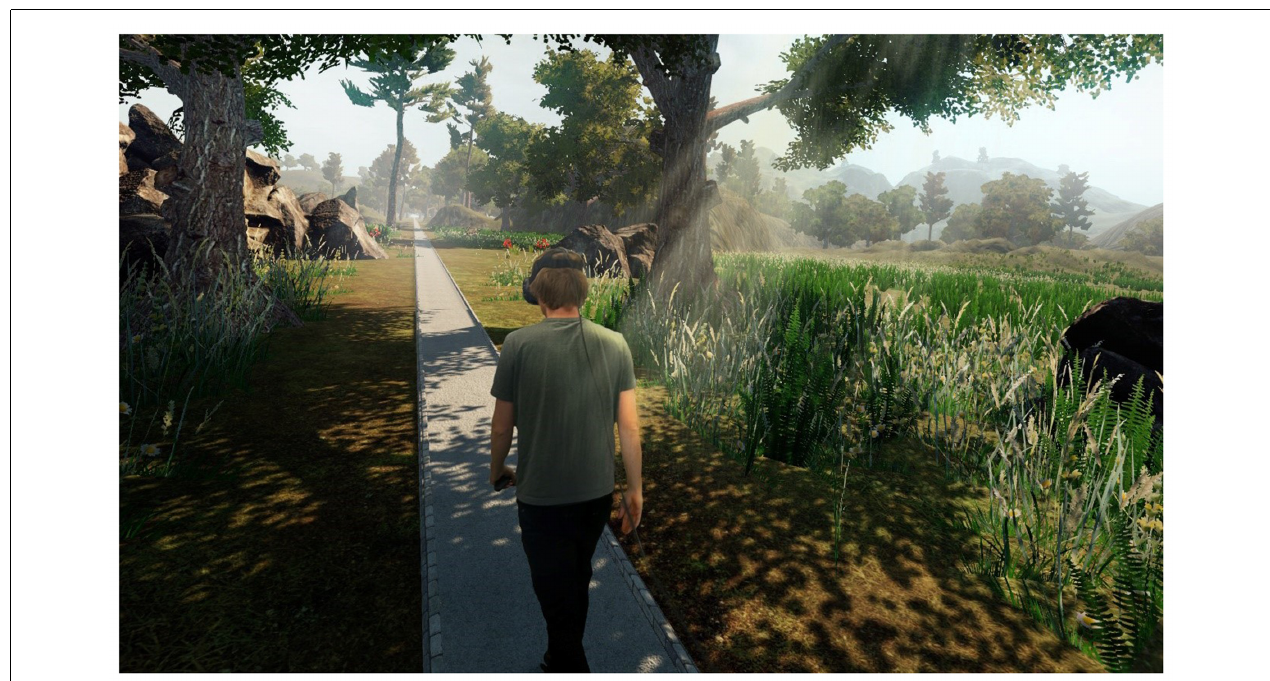
FIGURE 1 | The virtual environment of VR Walk is set to a Mediterranian